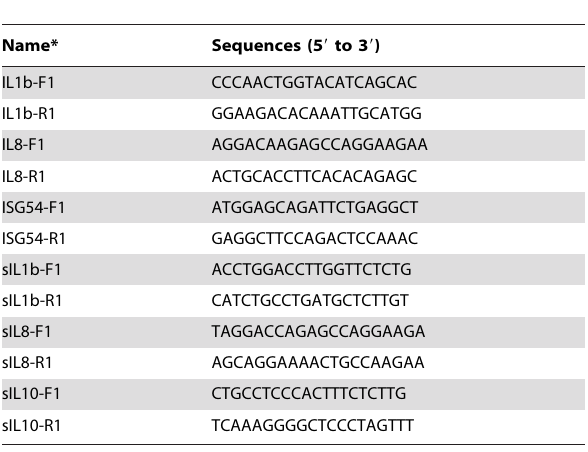
Table 1. List of primers for real-time